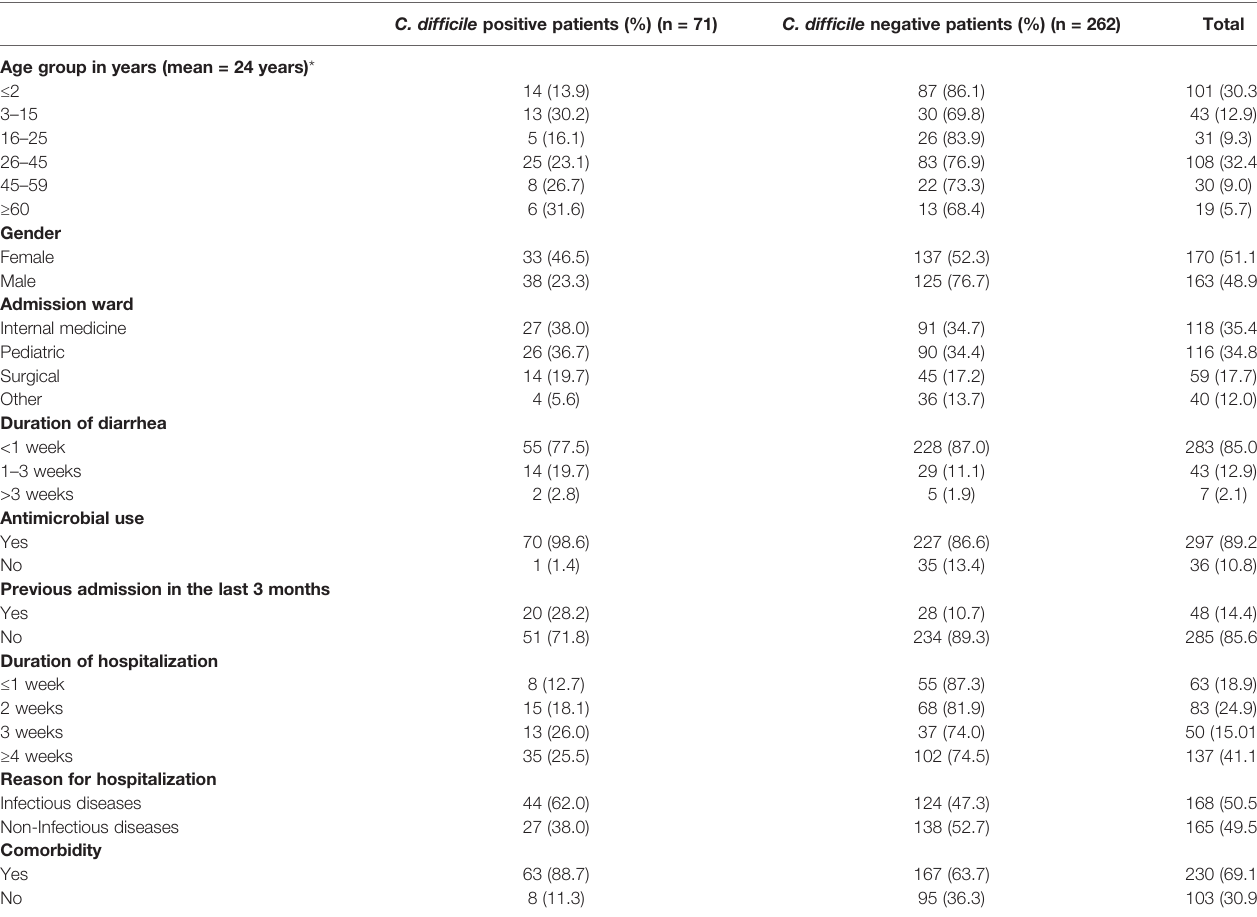
TABLE 1 | Demographic and admission information of the study patients (n =